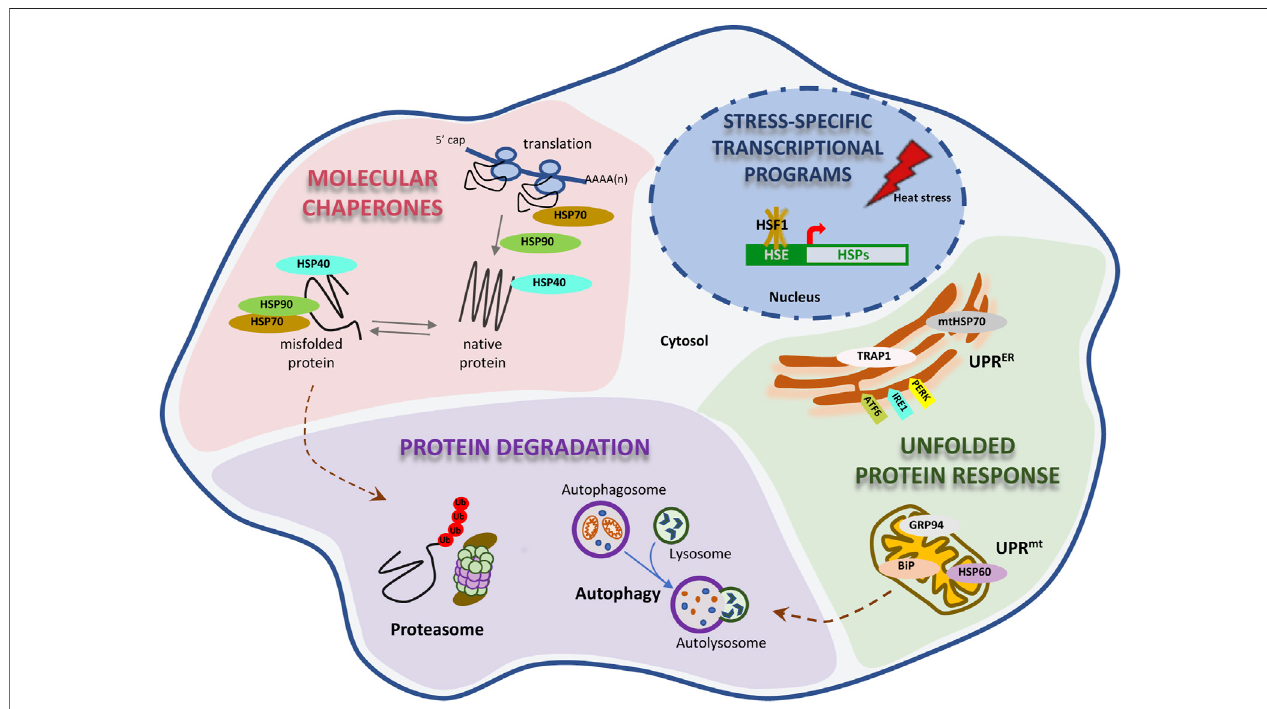
FIGURE1| Proteostasis ismaintainbyaproteostasisnetwork.Proteostasis hasmultiple levels ofregulation. Agreatnumber ofmolecular chaperonesarepresent in the cytosol, assisting on the appropriate folding and quality of the proteome. The proteosome and autophagy protein degradation pathways are essential for the clearance of unneeded proteins. Two distinct, but analogous, unfolded protein responses in the mitochondria and endoplasmic reticulum (mitoUPR and ER-UPR, respectively) are necessary to activate the expression of chaperones and to protect the function of these organelles from unfolding stress. Ultimately, the PN network is equipped with the adaptive activation of different transcriptional programs that get induced by different types of